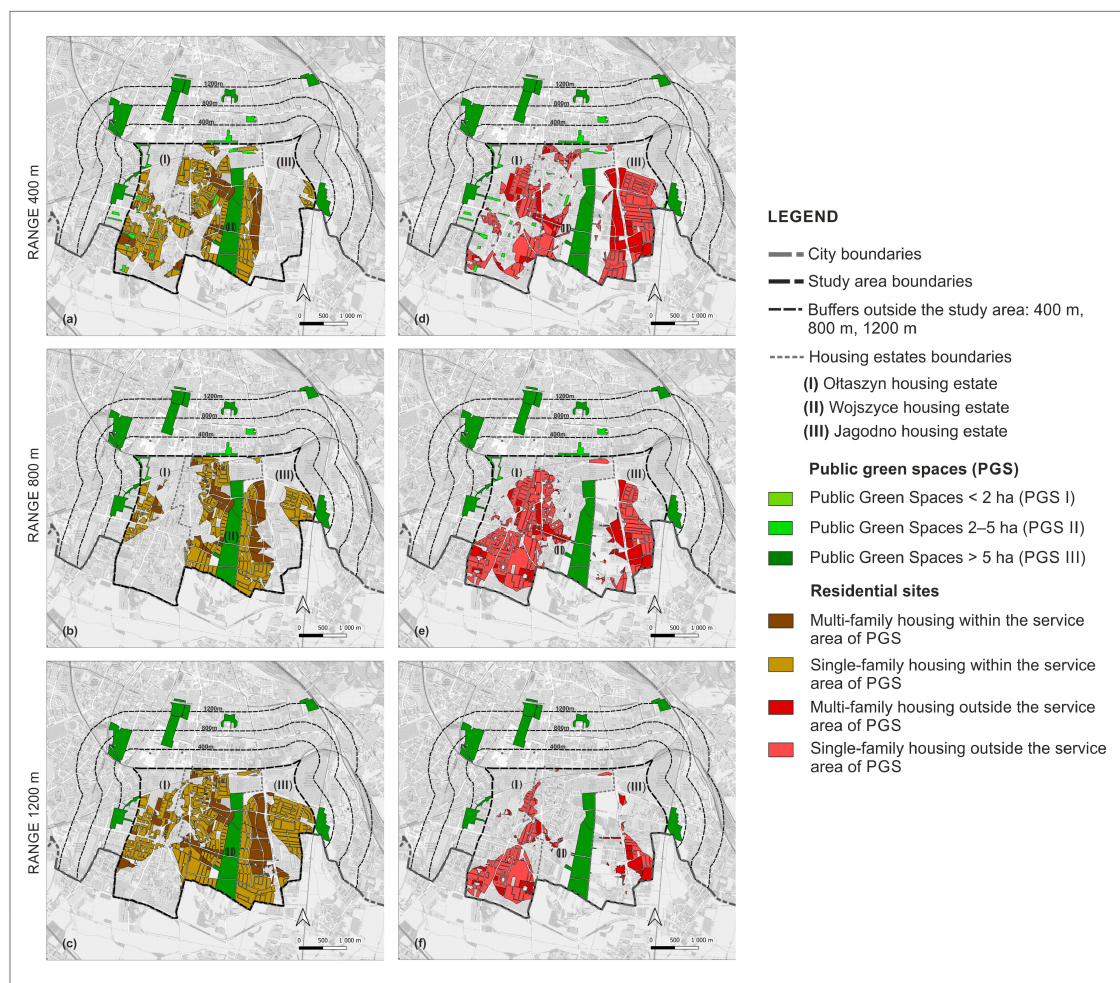
Figure 13. Residential sites located within the service areas of PGS according to land use plans: ( a ) within 400 m service area; ( b ) within 800 m service area; ( c ) within 1200 m service area; ( d ) outside